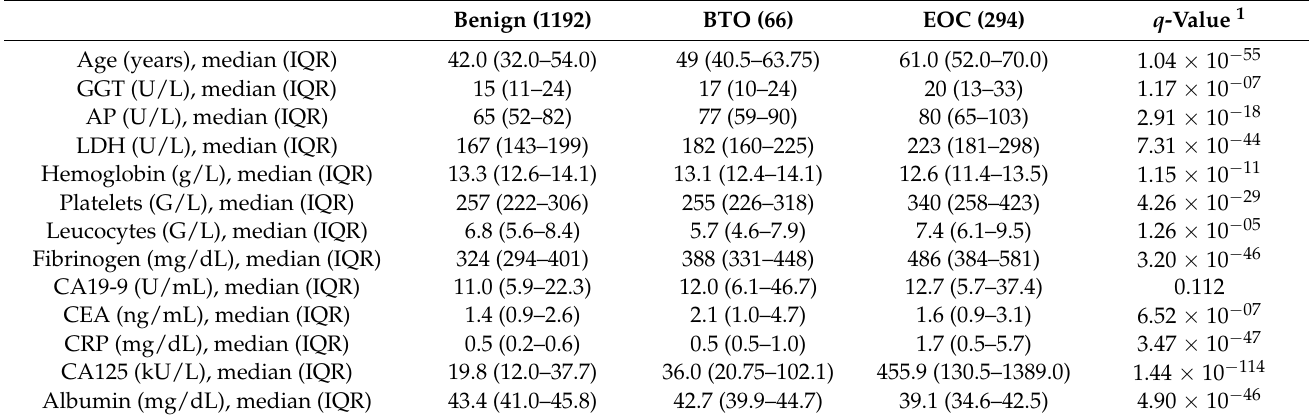
Table 1. Patients’ characteristics dependent on final histopathological result.